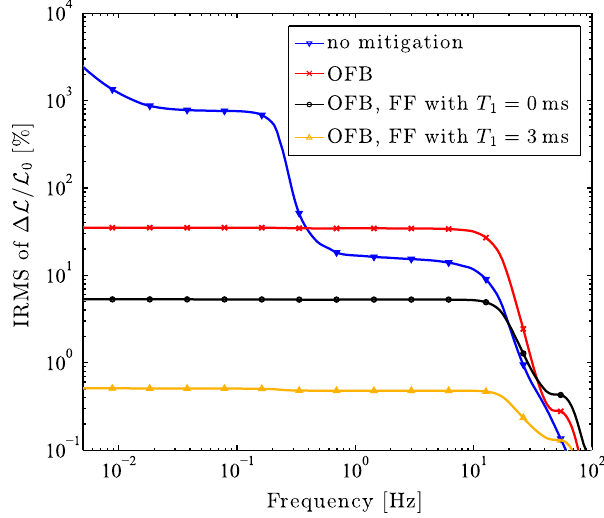
FIG. 3. Integrated root mean square of the relative luminosity loss Δ L = L 0 including the effect of the orbit feedback system (OFB) and the feed-forward system